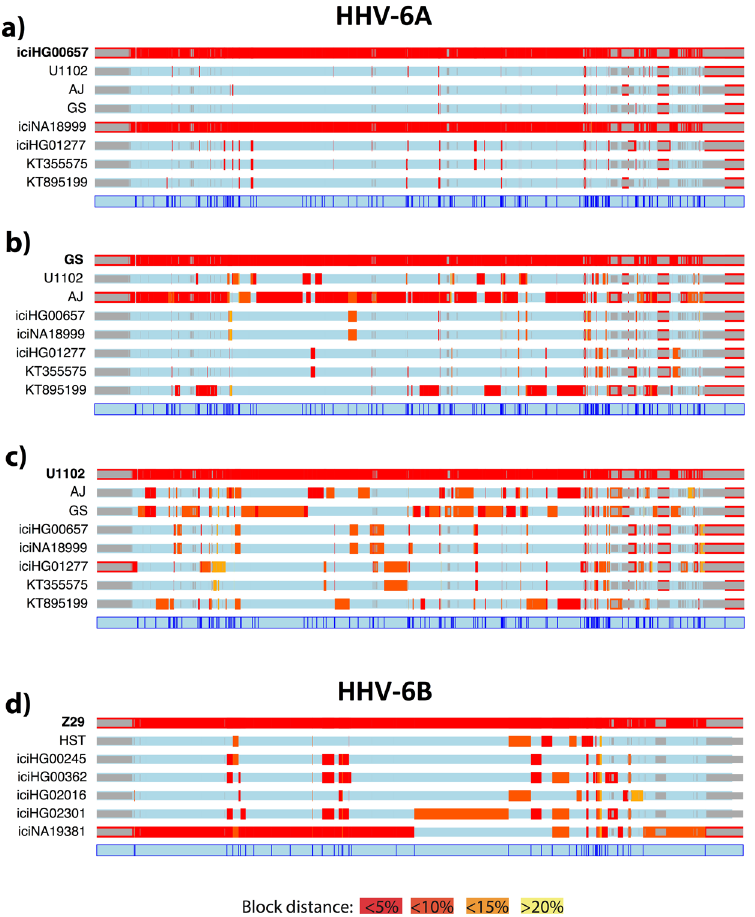
Figure 3. Recombination footprints. Recco analysis of the most cryptic HHV-6A ( a – c ), and HHV-6B ( d ) strains. The first row in each panel shows the analysed sequence, considered a recombination product of the rest of the species data set. The colour scale shows the proportional genetic distance, as shown in the appendix at the bottom of the figure. The masked regions of the genome are marked in grey.